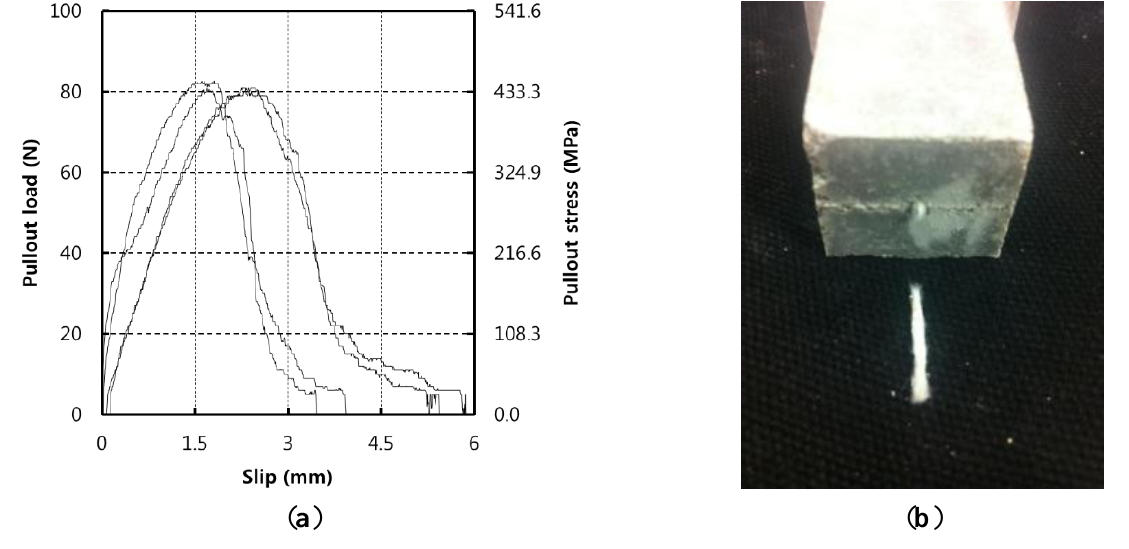
Figure 7. Pull-out test results. ( a ) Load-slip curve; ( b ) Fiber